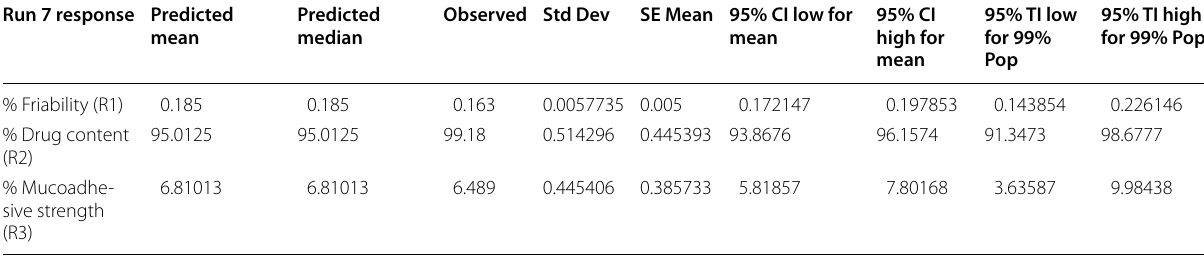
Two-sided, Confidence